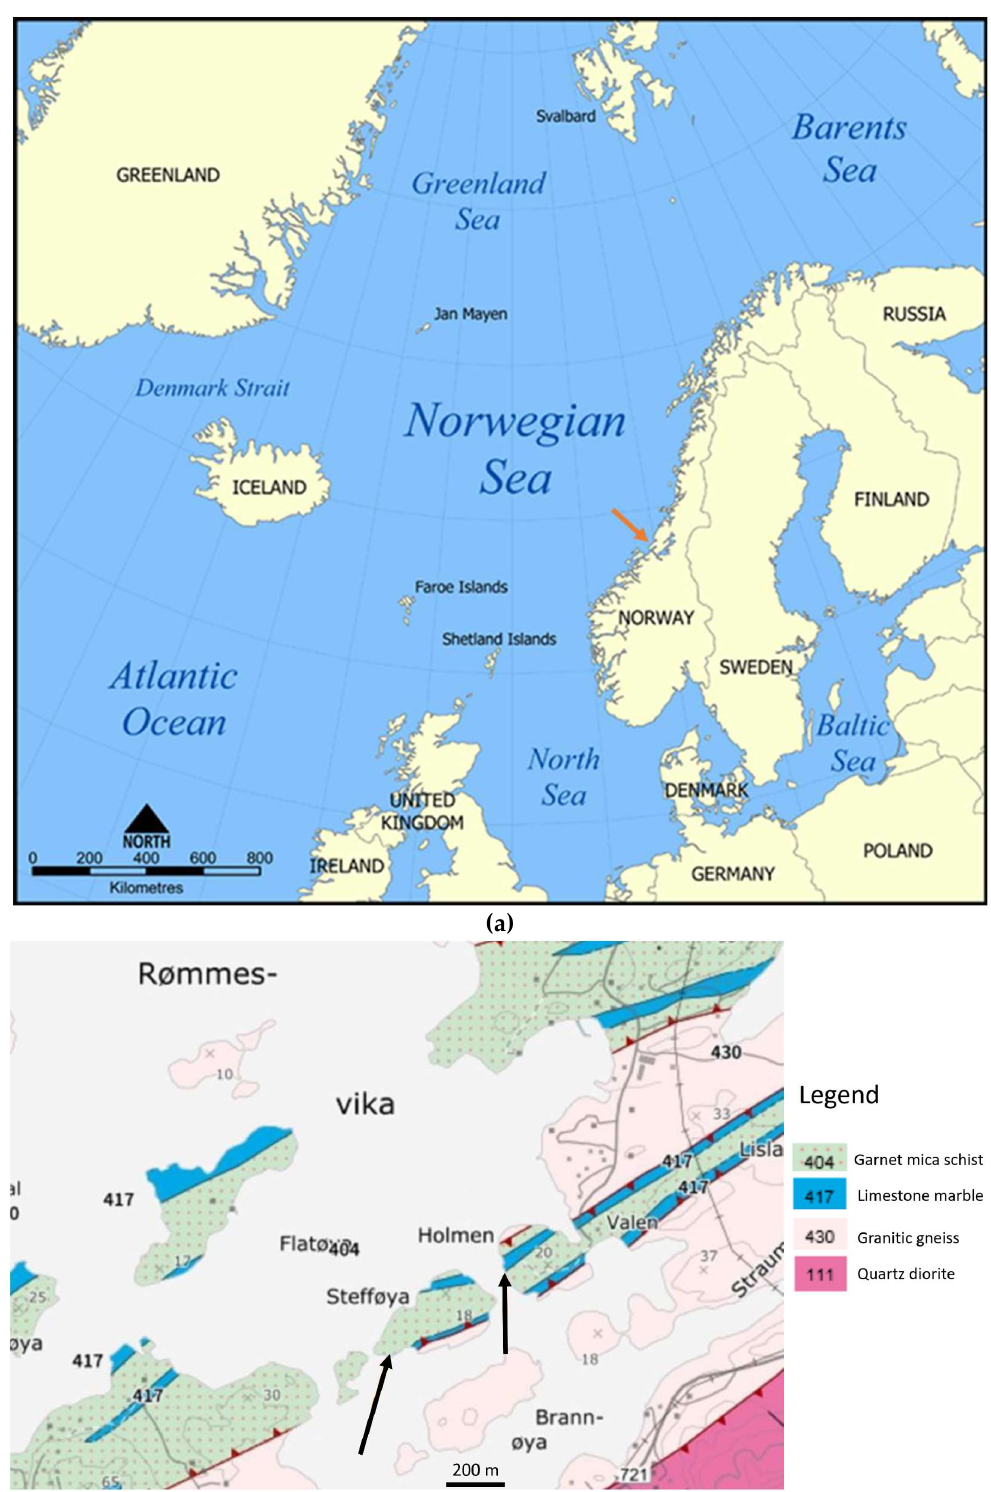
Figure 1. ( a ). Regional map with the sampling location indicated by the orange arrow (from CC BY- SA 3.0, https://commons.wikimedia.org/w/index.php?curid=292869, accessed on 20.12.2022); ( b ). geological map of the sampling sites at Stefføya and Valen indicated by the black arrows (from NGU Nasjonal berggrunnsdatabase [48]).